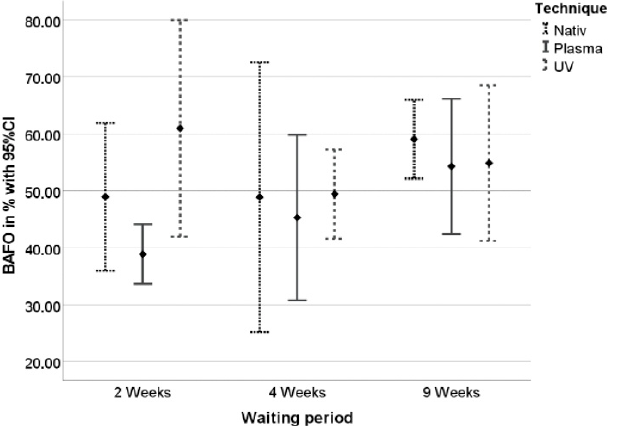
Figure 11. BAFO values in percent ± standard deviation after 2, 4, and 9 weeks of healing. Table 2. BAFO values after 2, 4, and 9 weeks of healing.